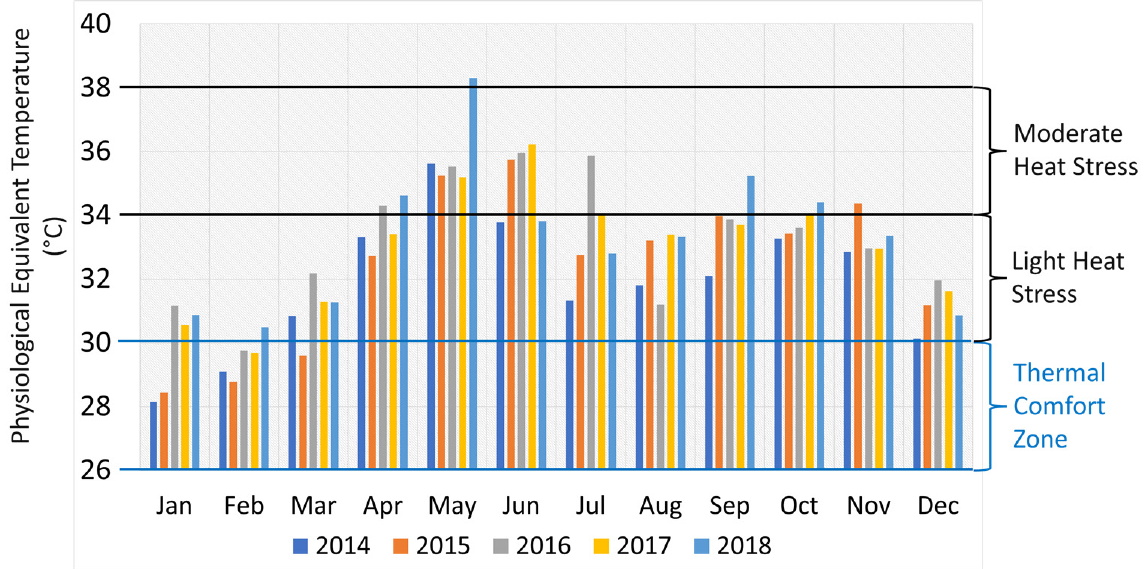
Figure 7. Monthly estimated Physiological Equivalent Temperature (PET) based on the RayMan model from 2014 to 2018.